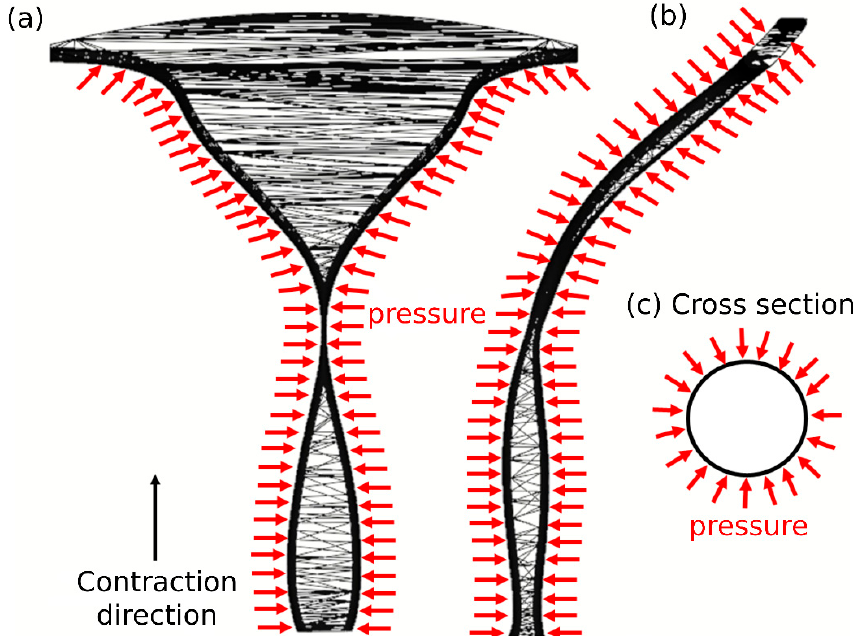
Figure 3. Pressure distributions along the 3D tract. ( a , b ) Side views of the direction of the pressure distribution. ( c ) Pressure distribution around a cross section of the 3D tract model.